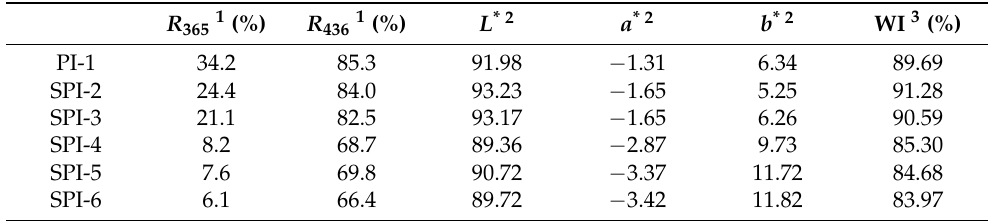
Table 4. Optical data of PI-1 and SPI NFMs.